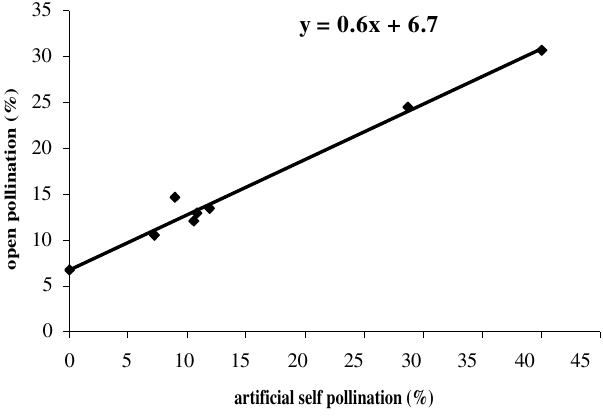
Figure 1. Correlation between artificial self pollination and free pollination in sour cherry cultivars